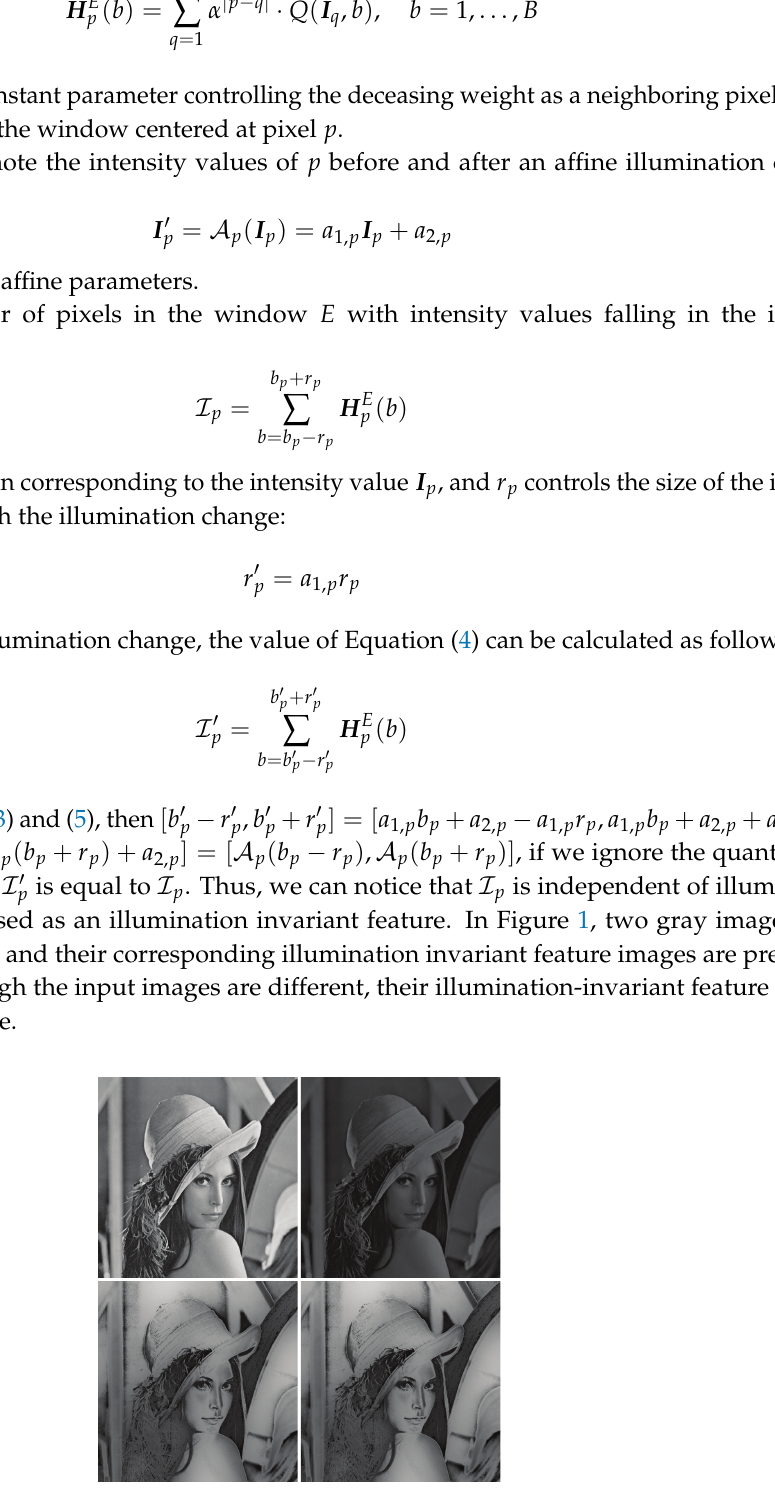
Figure 1. Illumination-invariant features (IIF). First row: input images with different illuminations. Second row: the corresponding illumination invariant feature